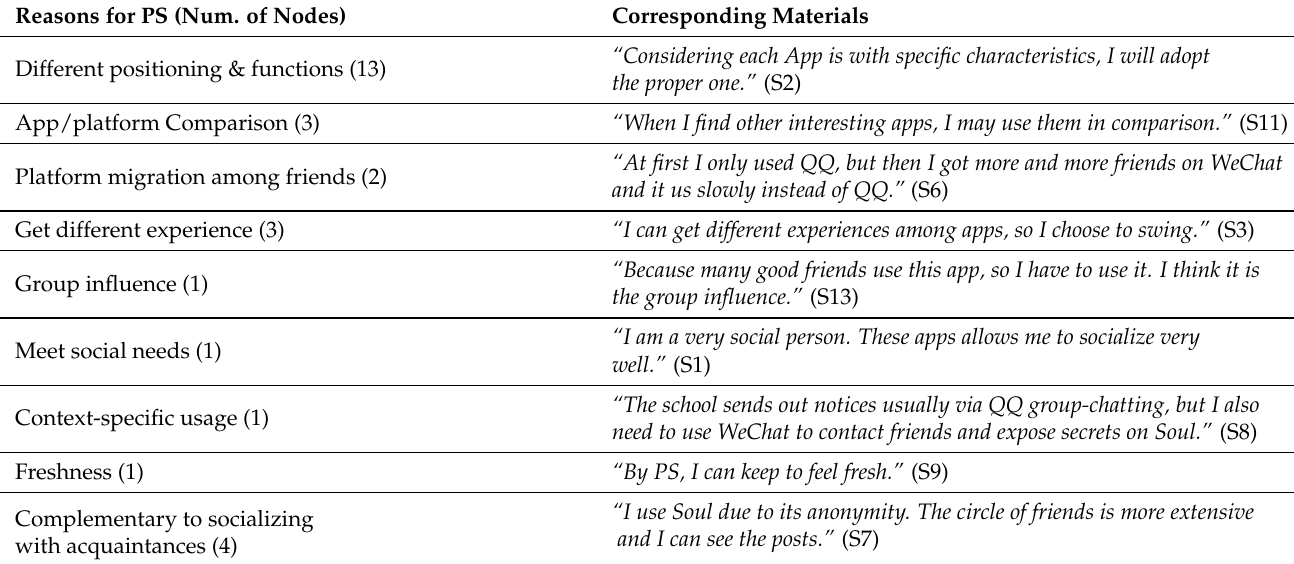
Table 5. Reasons for platform